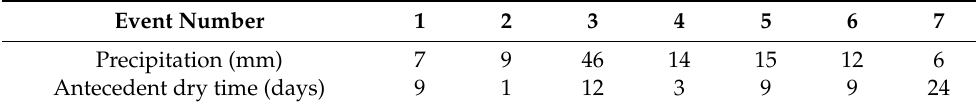
Table 4. Storm event number, precipitation volume, and antecedent dry time.